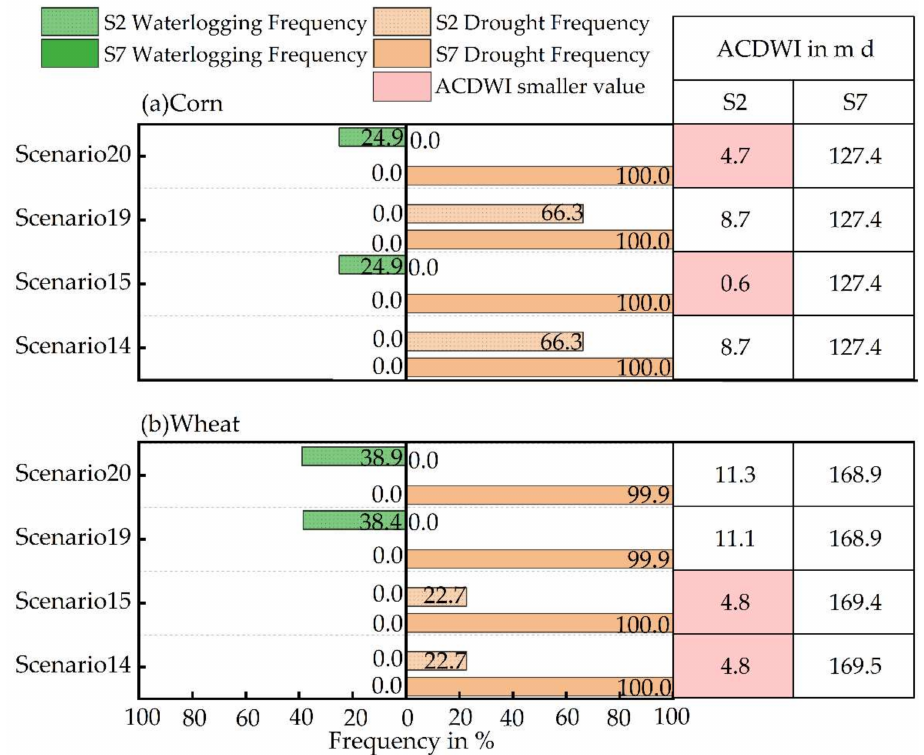
Figure 9. Drought and waterlogging stresses under different ditches’ water-depth scenarios in the southern section from 1989 to 2019, ( a ) corn growth period, ( b ) wheat growth